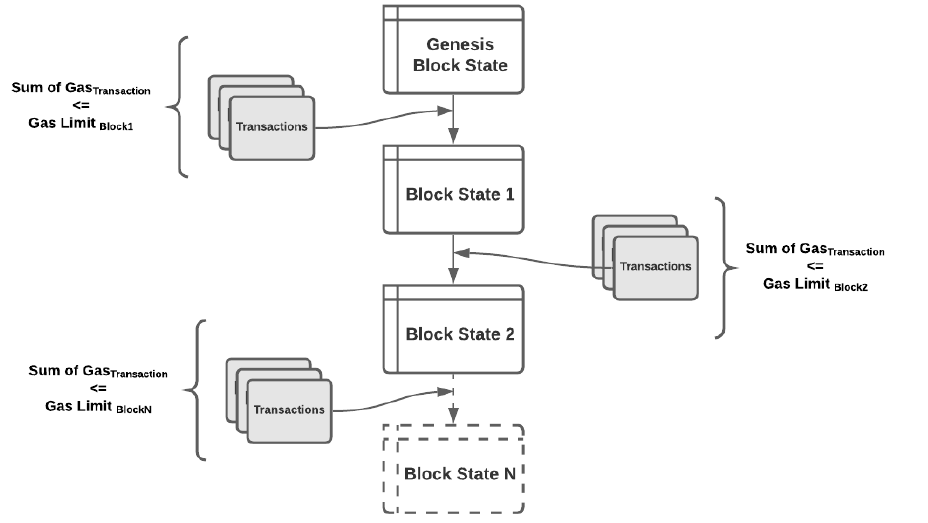
Figure 1. Block state with transactions